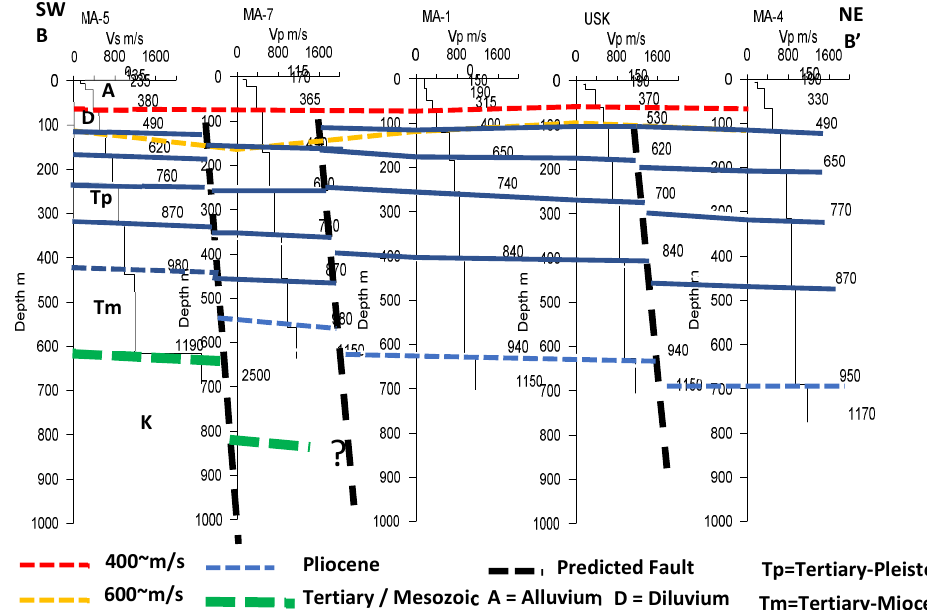
Figure 6. Shear-wave velocity (Vs) structure in the SW–NE